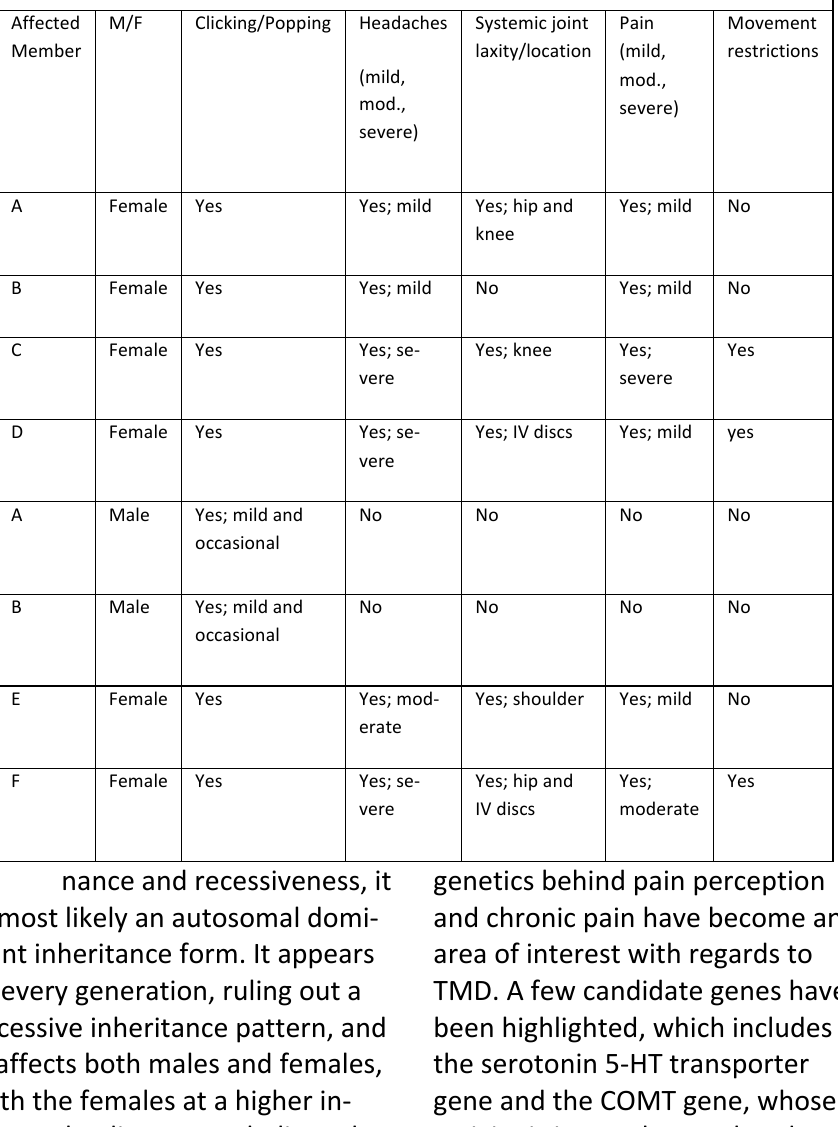
Table 1. Summary of clinical